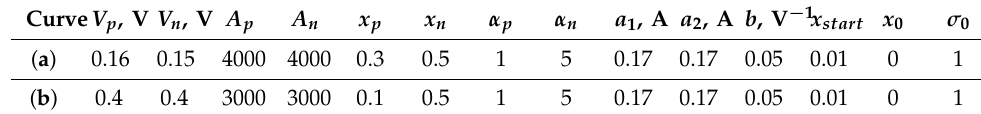
Table 3. Sets of parameters for Figure 8.